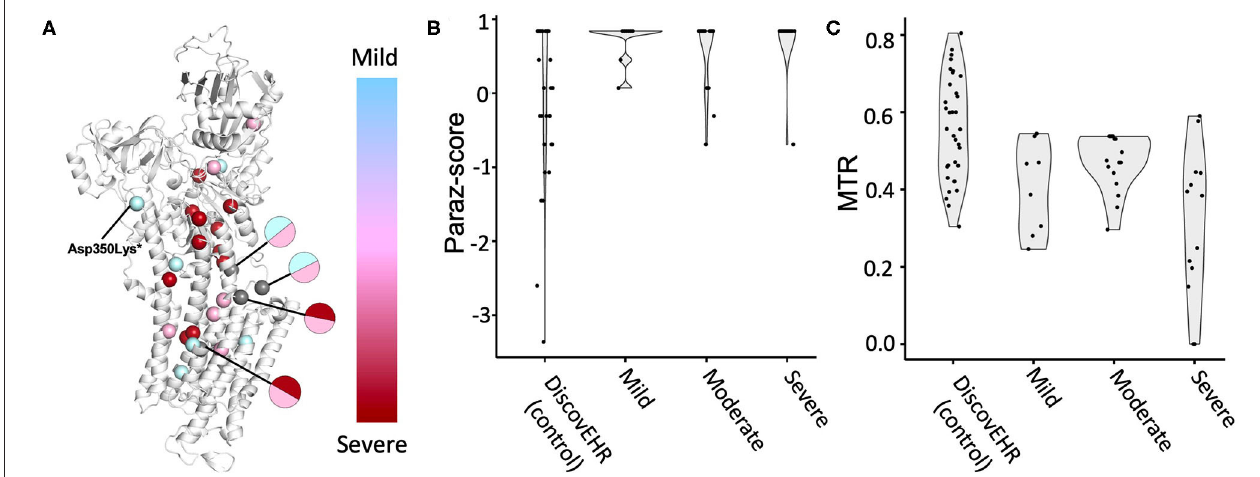
FIGURE 3 | ATP1A3 variant associated disorder severity and variant position analysis. Patients with ATP1A3 variants were grouped by disorder severity into three groups. (A) The corresponding missense variants were visualized on the protein structure and colored according to grouping (mild disorder = cyan; moderate disorder = pink; severe disorder = red). Gray-coloring of spheres indicates residues where variants from multiple severity groups have been reported. Amino acid residue paralog conservation (B) and population constrained (C) were assessed for variants from each severity group together with a neutral comparison group, missense variants from the DiscovEHR database (see methods in Supplementary Material for